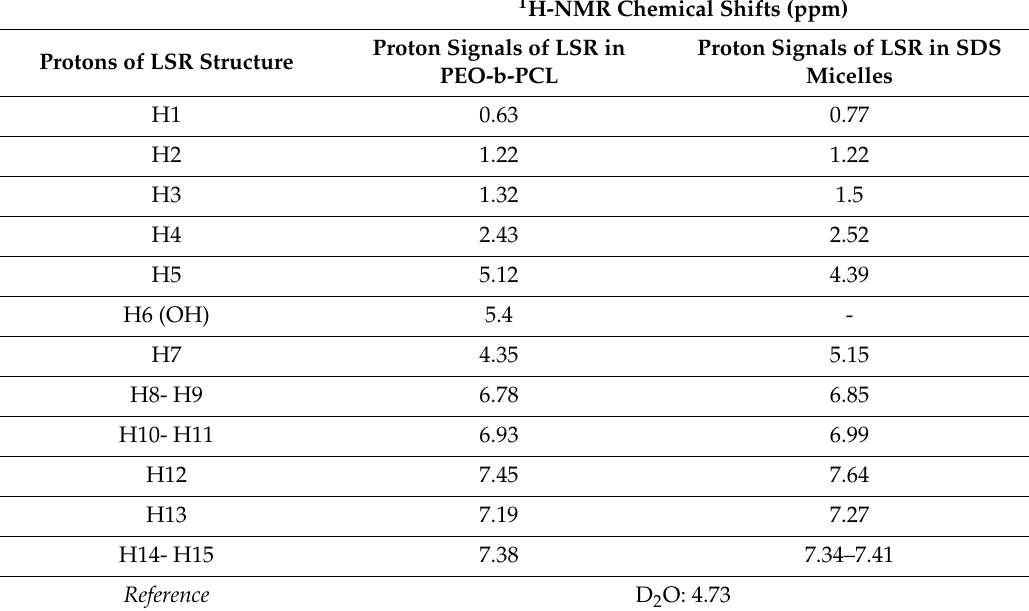
Table 4. H-NMR chemical shifts of LSR: (a) in the presence of PEO-b-PCL copolymer and (b) in the presence of sodium dodecyl sulfate (SDS) micelles in D 2 O